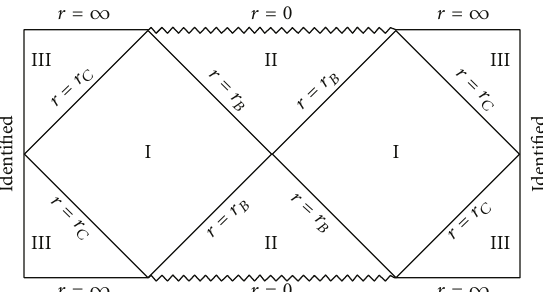
Figure 1: Penrose diagram for SdS black hole